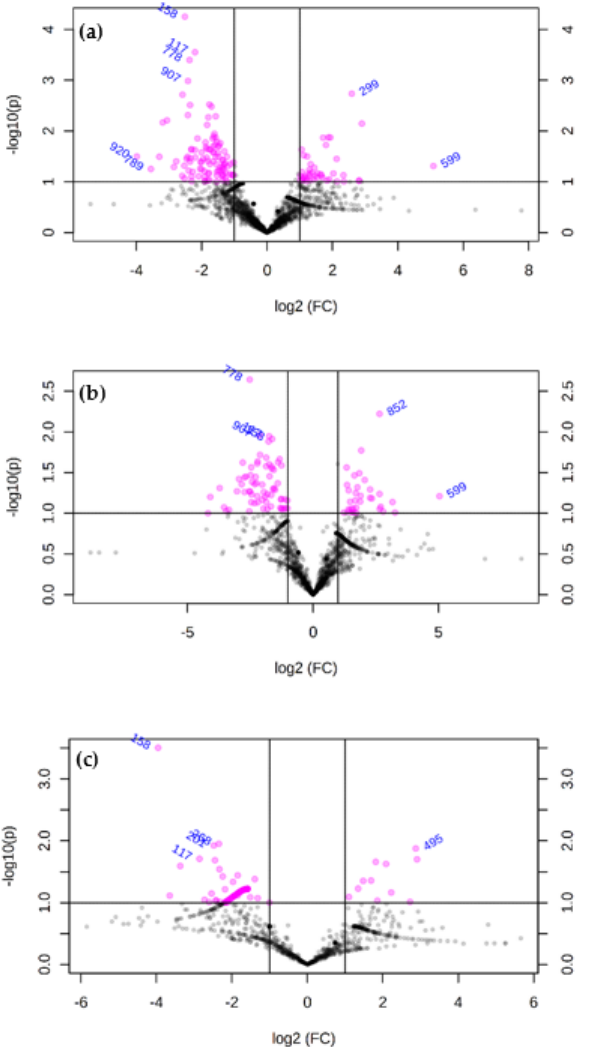
Figure 3. Volcano plot showing the OTUs that differ significantly between groups of study: ( a ) GP and GN, ( b ) GPF and GNF, and ( c ) GPM and GNM. The pink points indicate variables of interest that display both large-magnitude fold changes ( x -axis) as well as high statistical significance ( − log10 of p -value Wilcoxon test, y -axis). The horizontal line shows the p -value cut-off ( p -value = 0.10), with points above the line having a p - value < 0.10 and points below the line having a p - value > 0.1. The vertical lines show 2-fold changes. The outputs of the PLS-DA analysis, applied to the previously identified significant OTUs, were shown using the scores plots and the variable importance in projection plots (Figure 4).